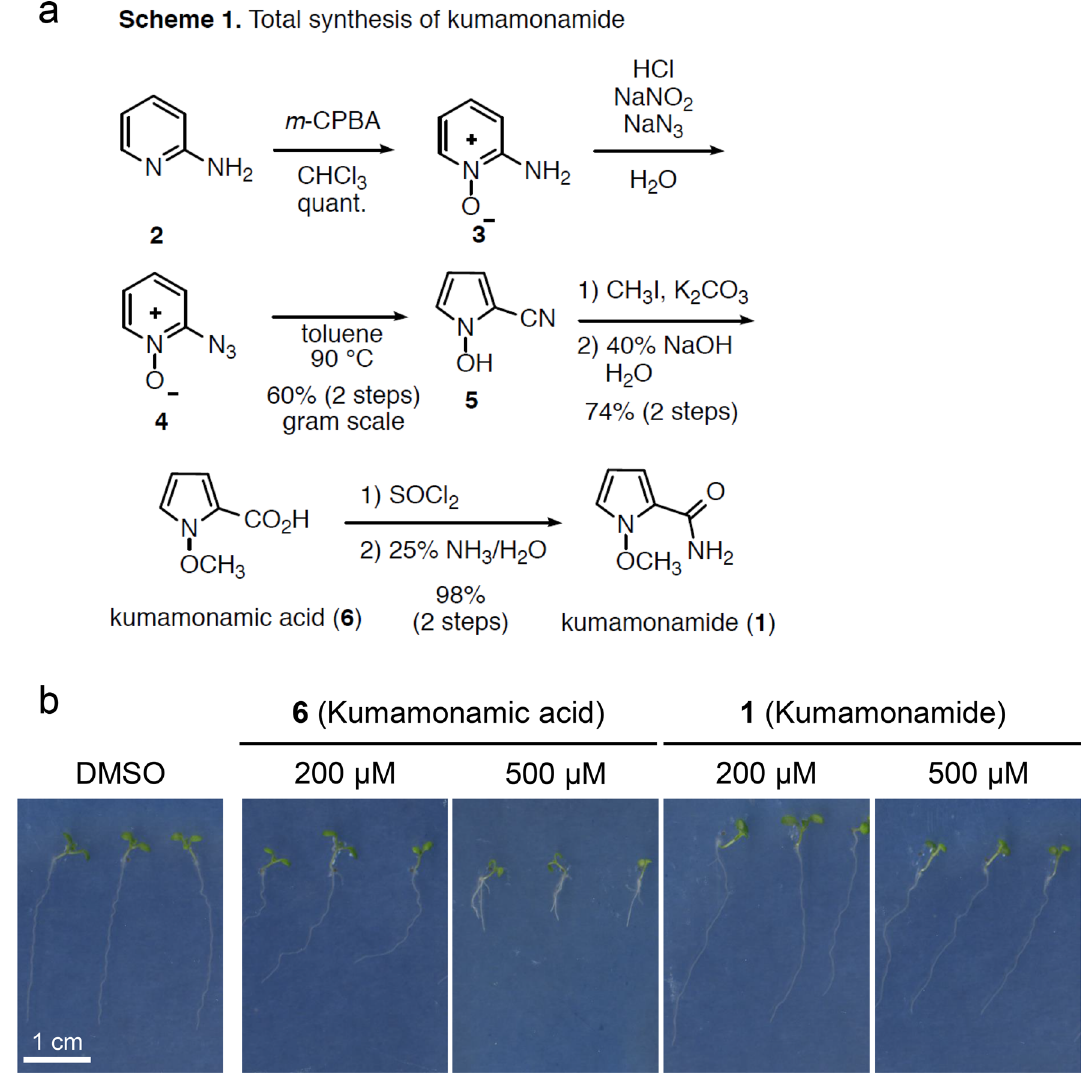
Figure 2. Total synthesis and bioactivity analyses of kumamonamide and kumamonamic acid. ( a ) Total synthesis of kumamonamide. ( b ) Seven-day-old, wild-type Arabidopsis Columbia (Col) seedlings were grown on Murashige and Skoog (MS) plates with the indicated concentrations of kumamonamic acid 6 or kumamonamide 1 . Scale bar = 1